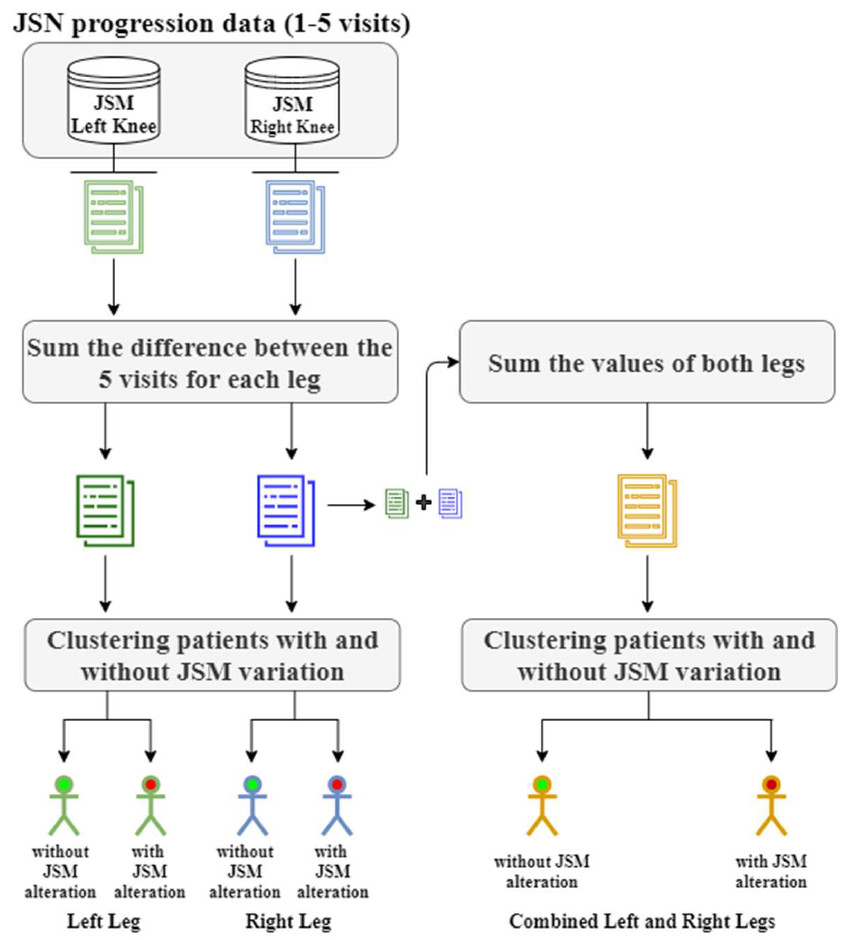
Figure 2. Clustering process of the proposed methodology. JSM: Joint space narrowing on medial compartment.